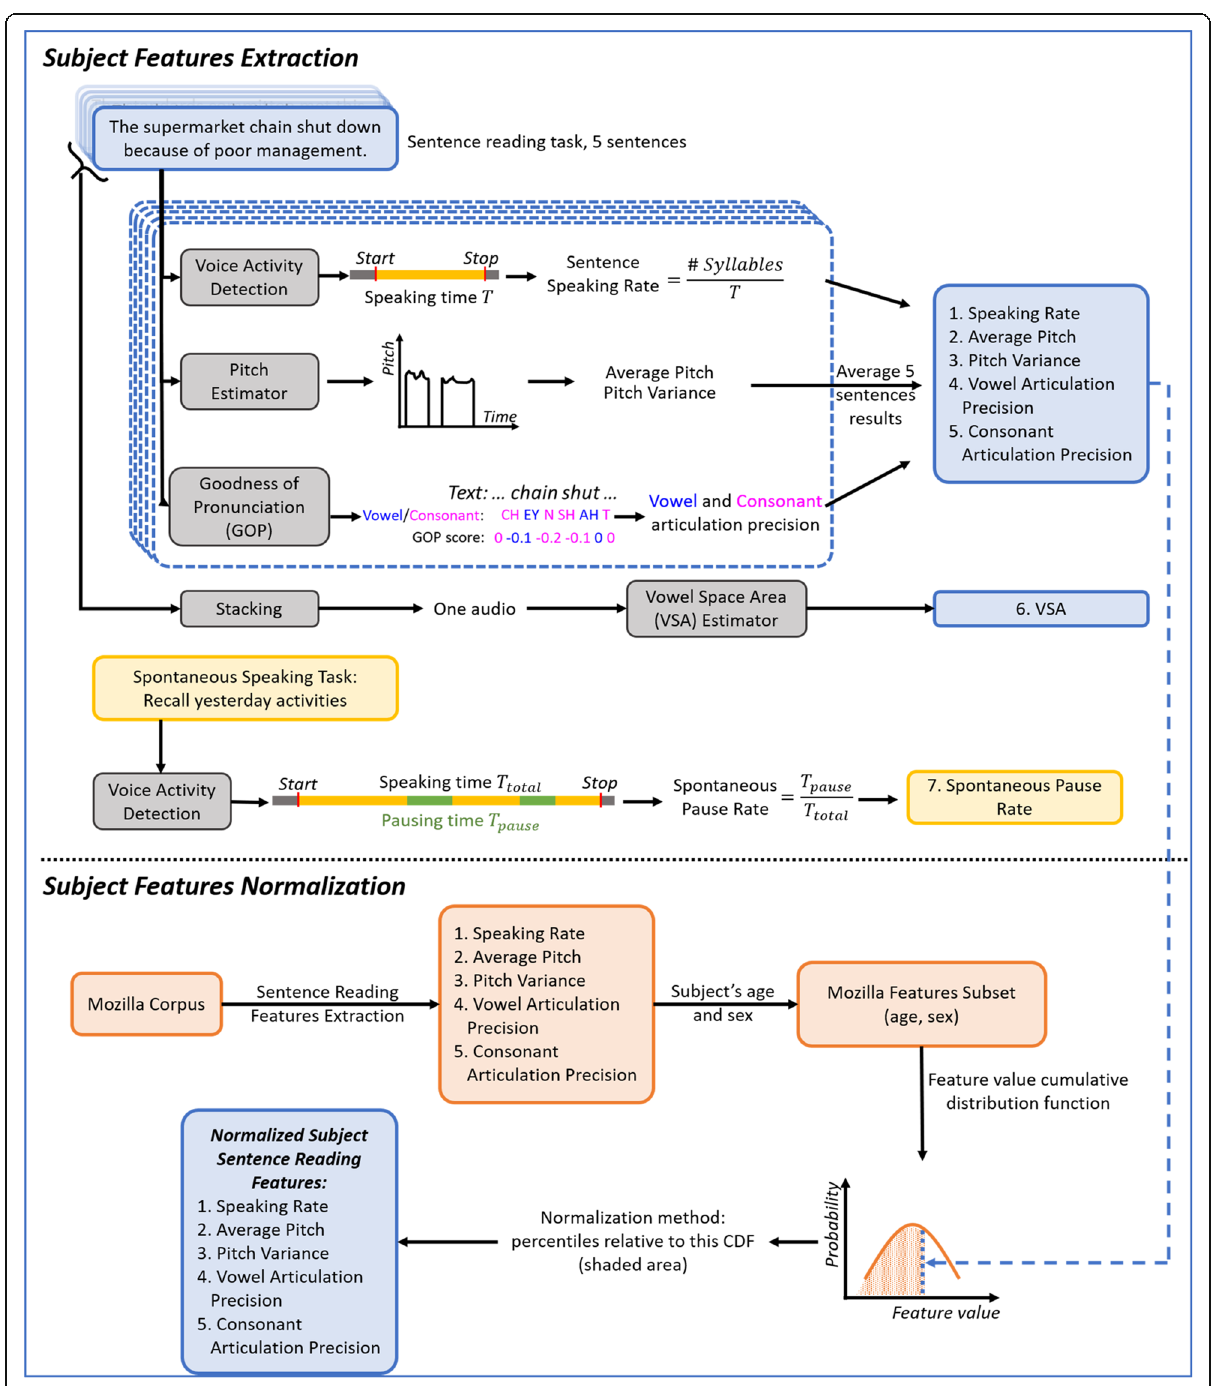
Fig. 1 Speech feature extraction and normalization procedure for the sentence reading tasks and the spontaneous speaking